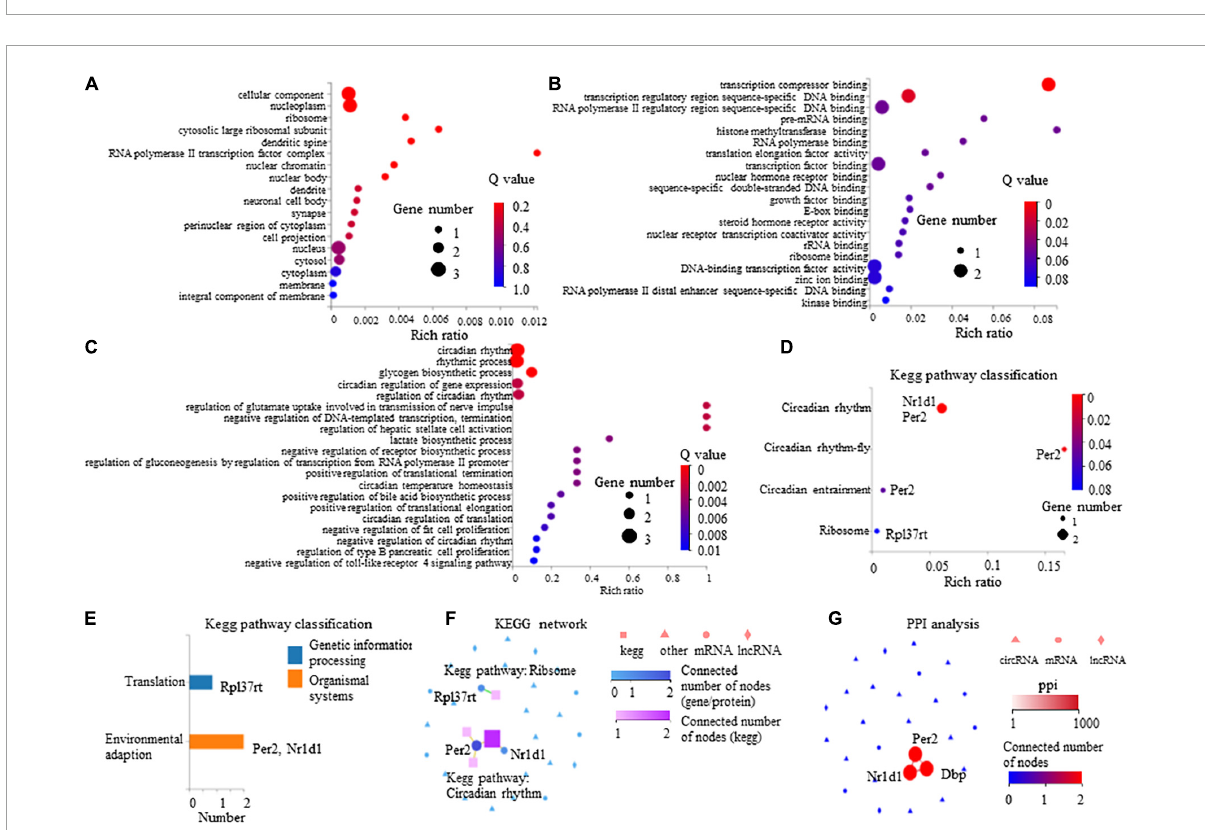
FIGURE6 Gene Ontology (GO) enrichment analysis and Kyoto Encyclopedia of Genes and Genomes (KEGG) pathway of eight differentially expressed mRNAs in paclitaxel (PTX)-treated mice. (A) GO cellular component analysis. (B) GO molecular function analysis. (C) GO biological process analysis. (D) KEGG pathway enrichment analysis. (E) KEGG pathway classification analysis. (F,G) Connection between Nr1d1 , Per2 , and Dbp shown by KEGG network (F) and protein-protein interactions (PPI) analysis (G)